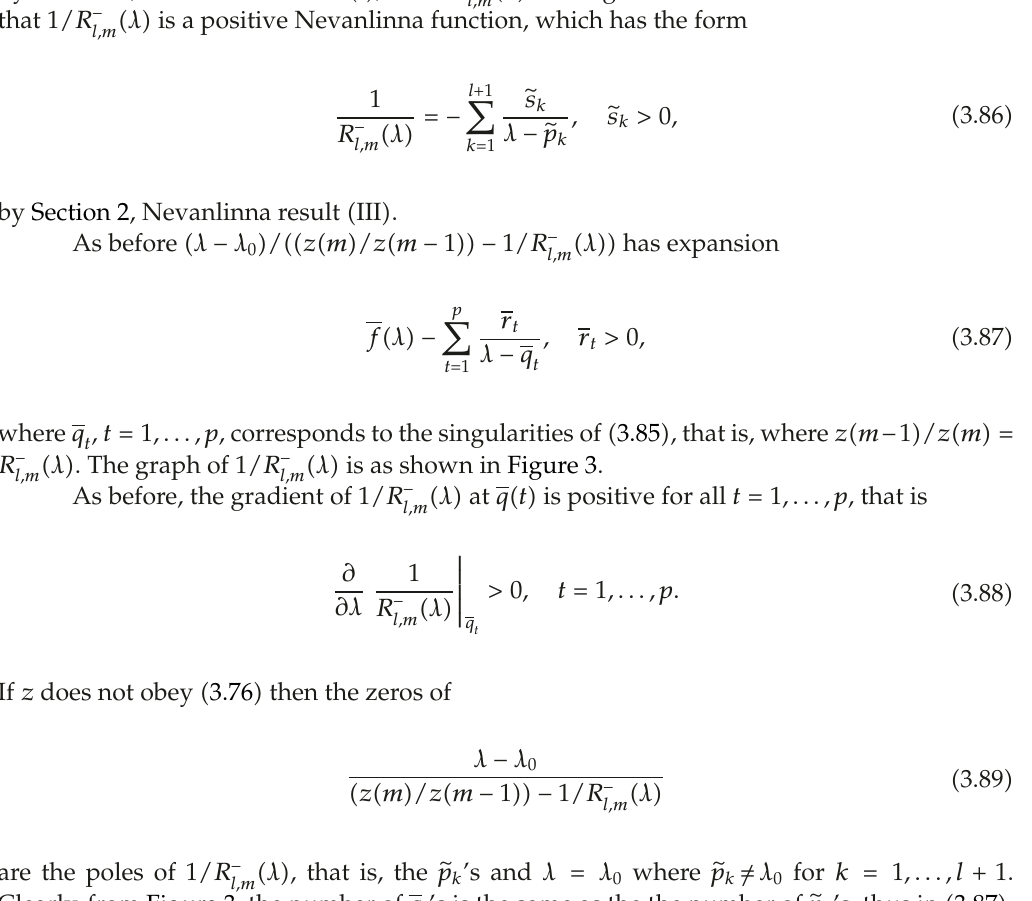
(cid:2) λ (cid:3) l,m